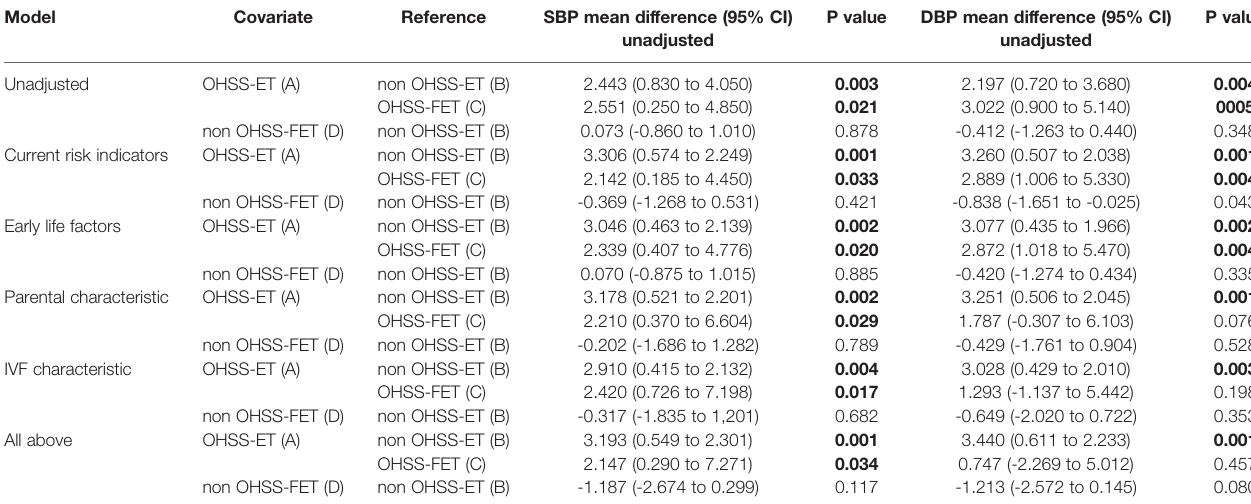
TABLE 5 | Multiple linear regression analysis of the effect of OHSS on blood pressure.